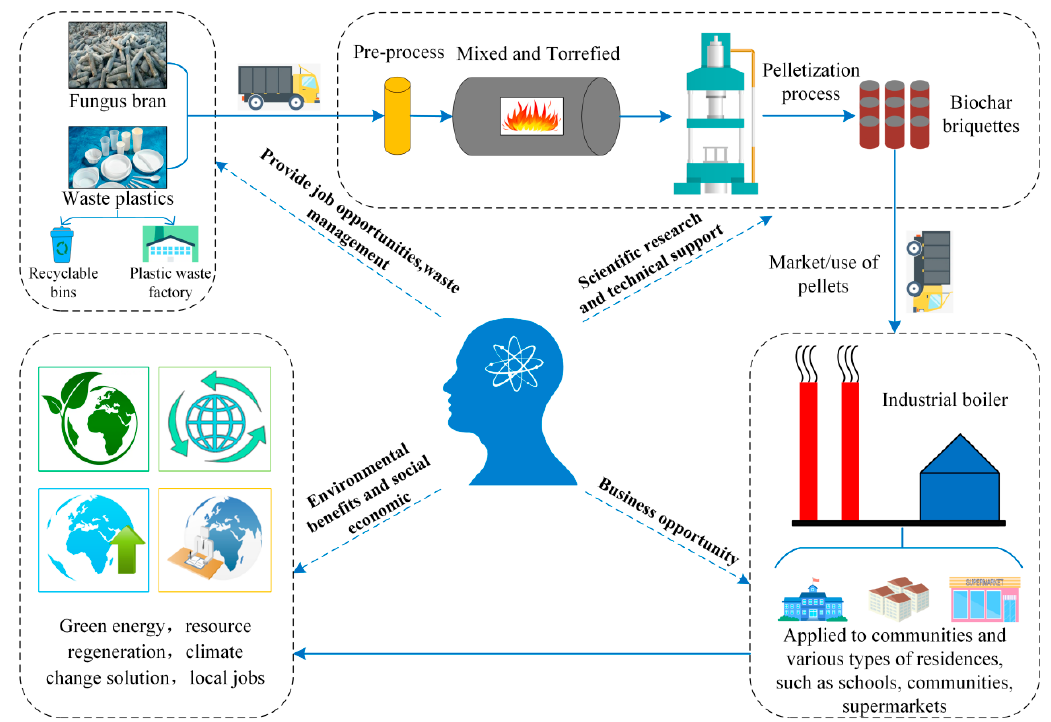
Figure 10. Biofuel circular economy framework.